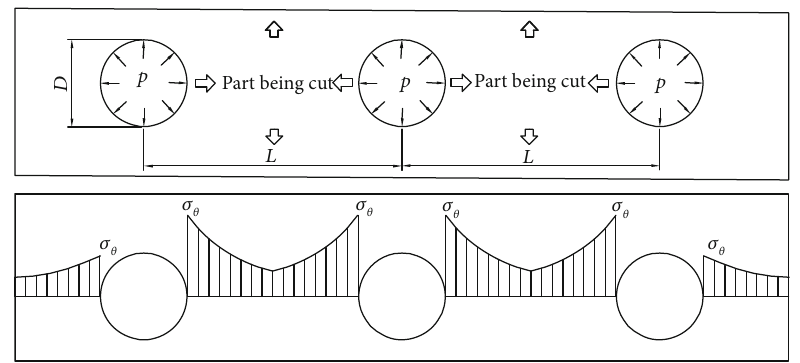
Figure 7: Distribution of tangential stress of multihole linear codirectional hydraulic fracturing.